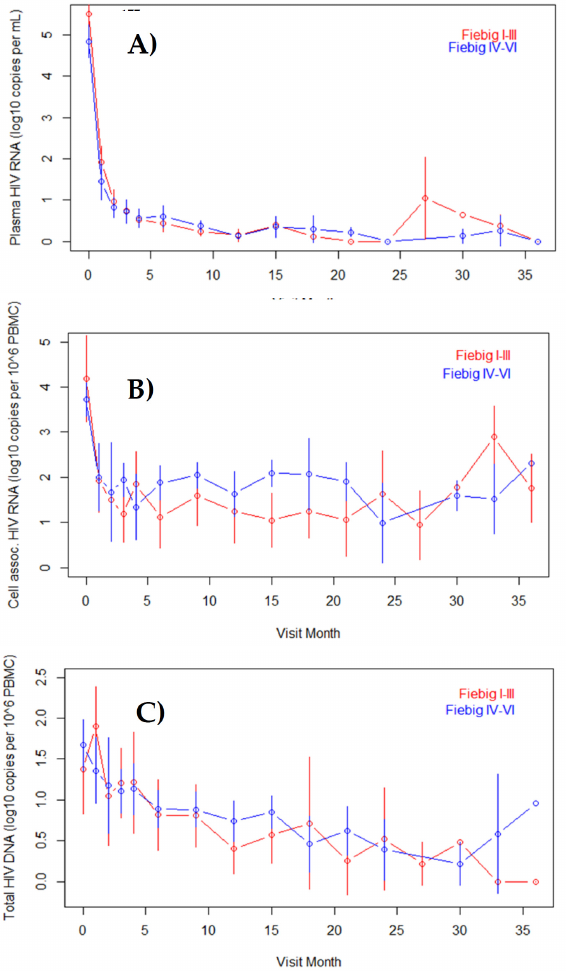
Figure 1. HIV reservoir parameters (means and 95% confidence intervals) for rapidly treated acute and recent HIV infections by month of treatment and Fiebig stage subgroup. Panels represent: ( A ) plasma HIV RNA by ultrasensitive assay; ( B ) cell-associated HIV RNA; and ( C ) cell-associated total HIV DNA. Multivariable negative binomial models for HIV reservoir analytes versus Fiebig stage category are shown in Table 2. The exponentiated model coefficients can be inter- preted similarly to odds ratios. Ultrasensitive plasma HIV RNA was inversely associated with Fiebig stages I–III (odds = 0.14) and months of ART treatment (odds 0.61 per month).